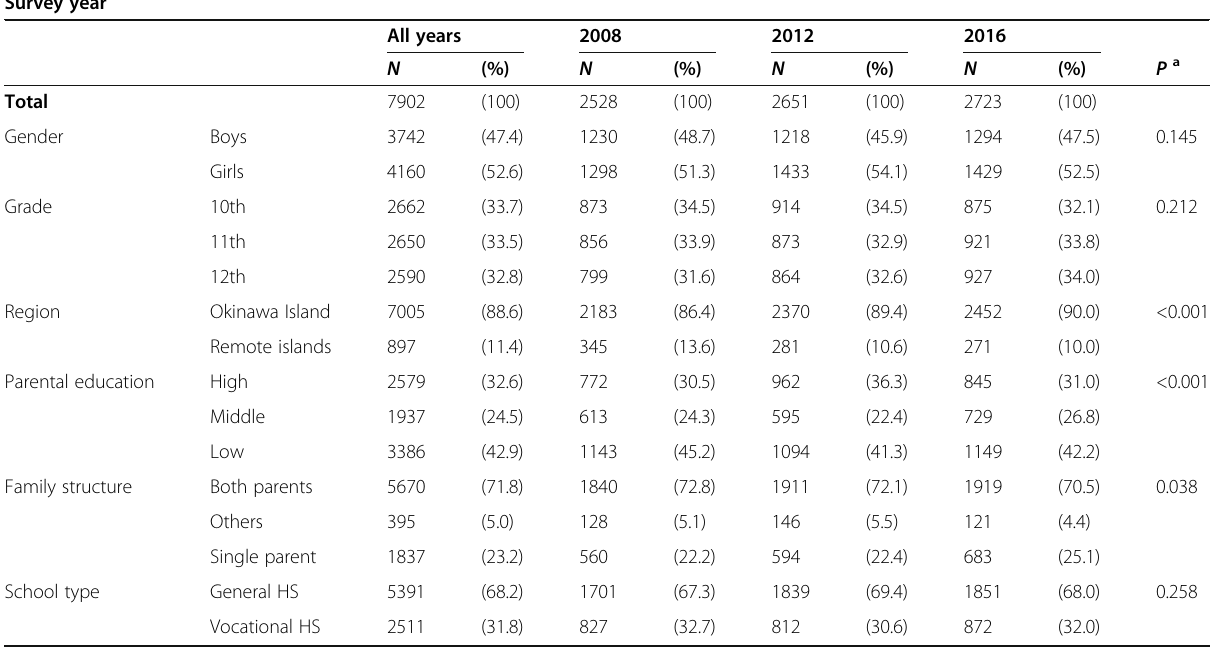
Table 1 Distribution of study participants by sociodemographic characteristics Survey